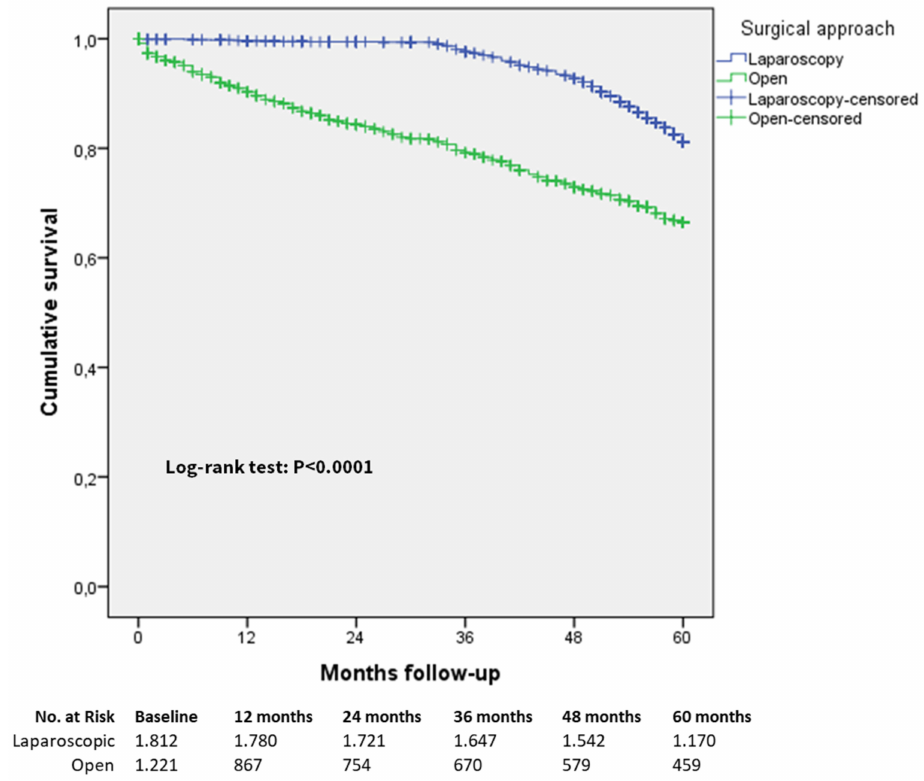
Figure 3. Five-years overall survival, entire cohort (all patients).